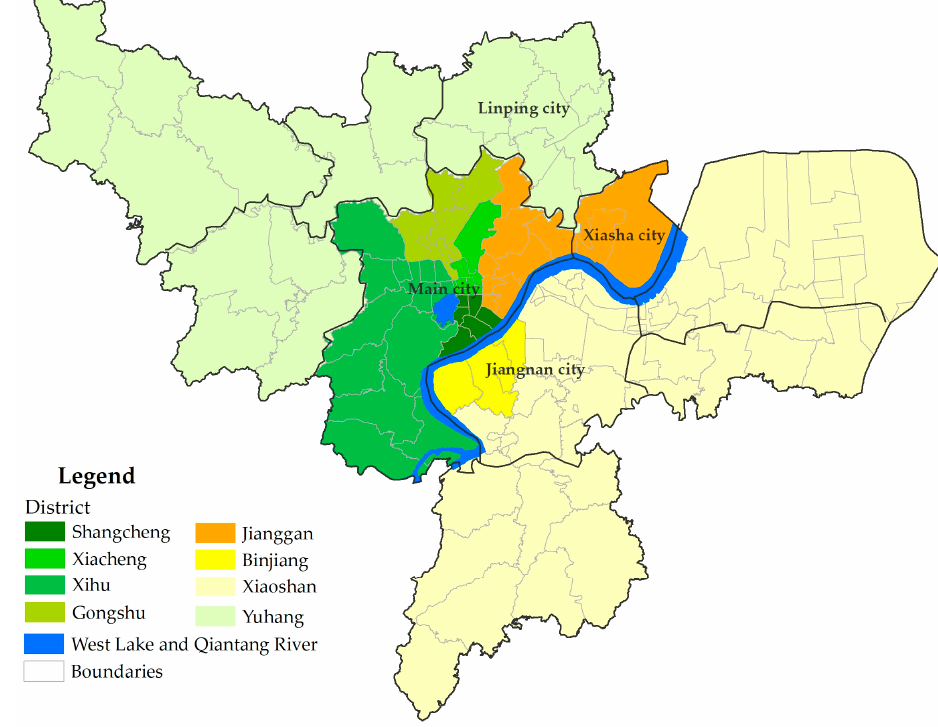
Figure 1. Overview of the study area.